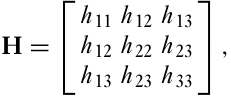
Figure 11 Case 4: extreme